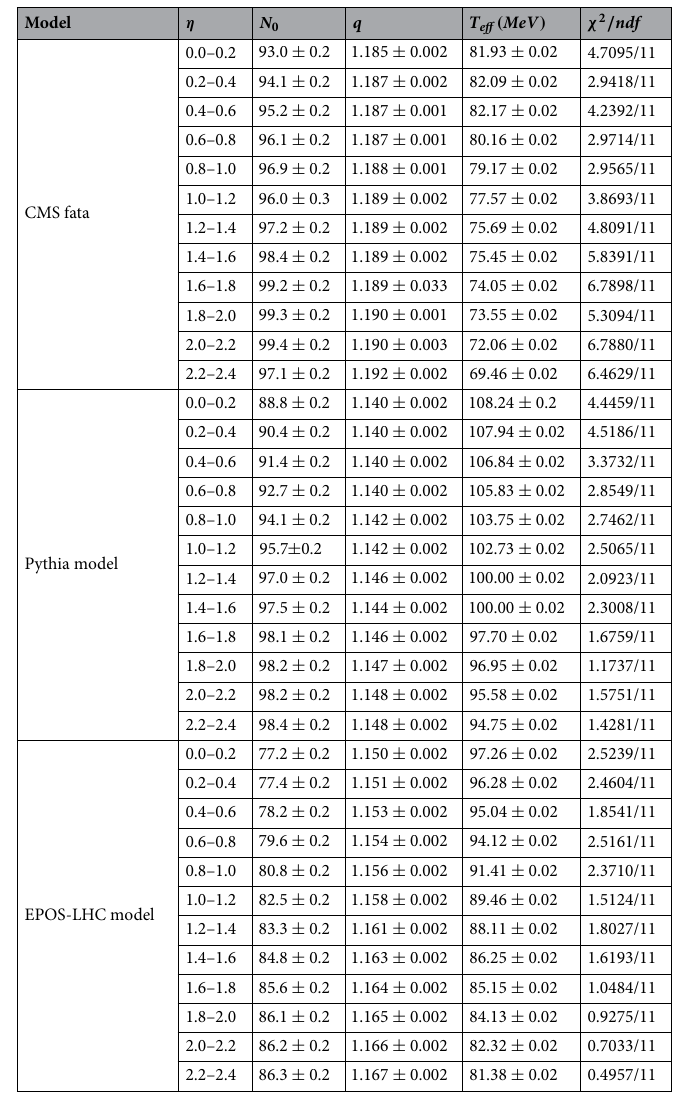
2 / ndf at different